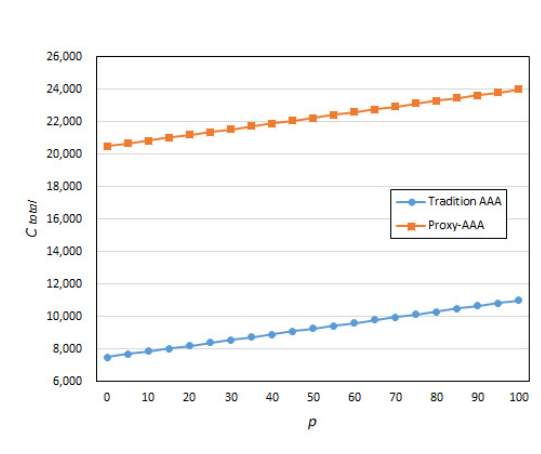
Figure 13. Figure 12 Total overhead ( (cid:12) = 0 : 01 , (cid:21) = 1 ).